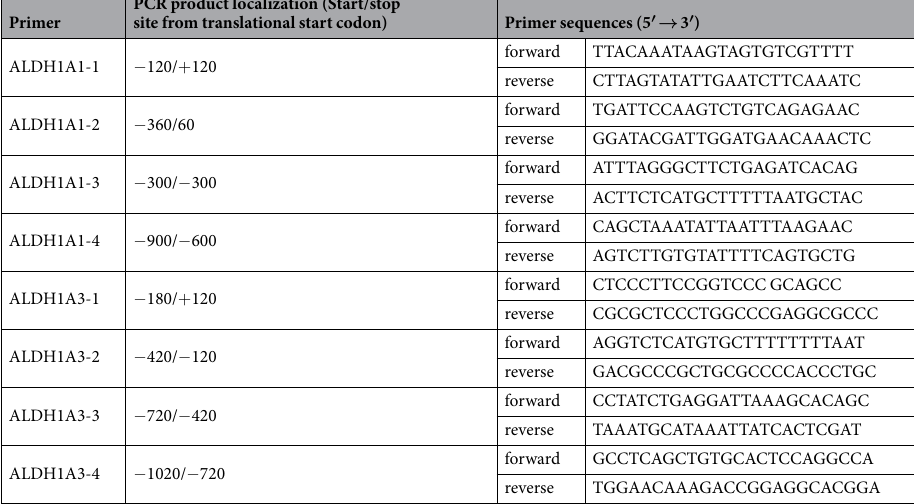
Table 1. Primers for ChIP